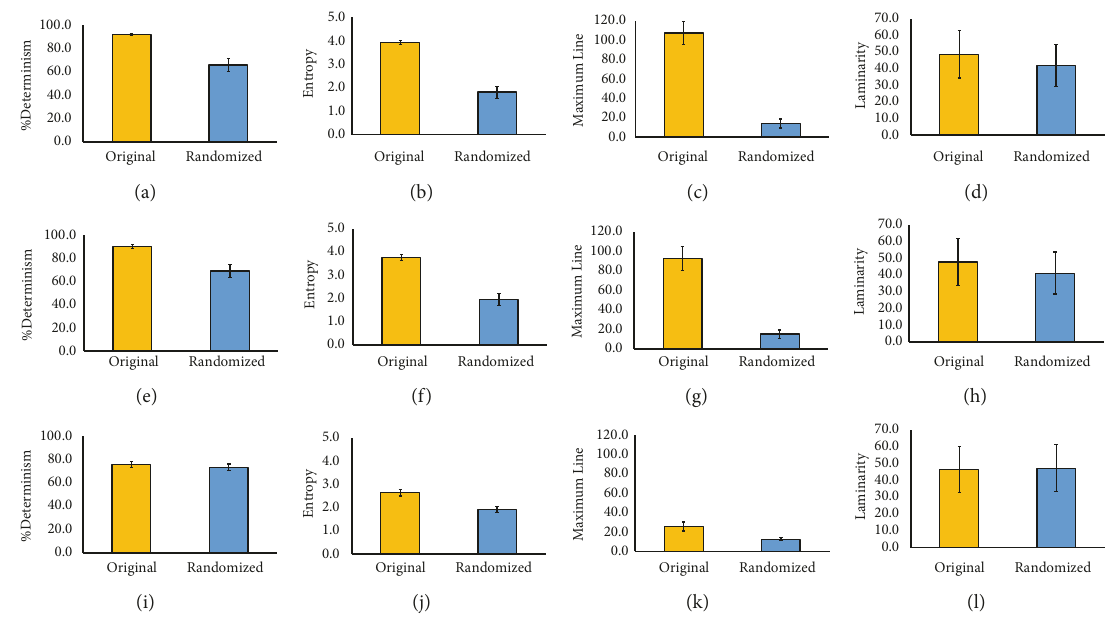
Figure 3: Mean and standard errors of determinism (Panels (a), (e), and (i)), entropy (Panels (b), (f), and (j)), maximum line (Panels (c), (g), and (k)), and laminarity (Panels (d), (h), and (l)), segmenting by words, verbal expressions and grammar, and body movements.